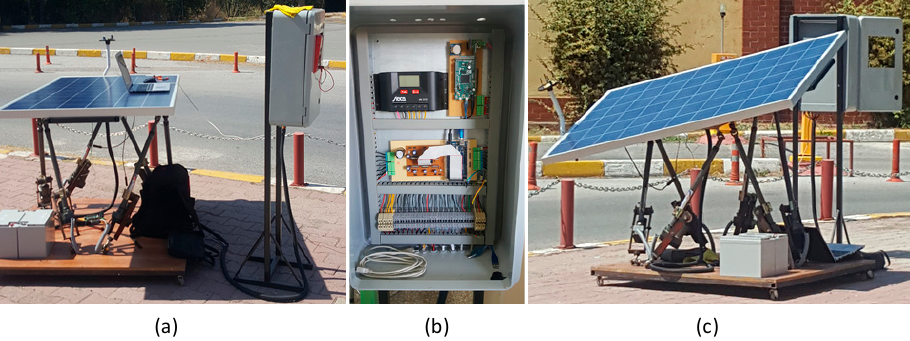
Figure 12. ( a ) Installation of the solar tracker, ( b ) wiring control panel, ( c ) testing of the solar tracker.